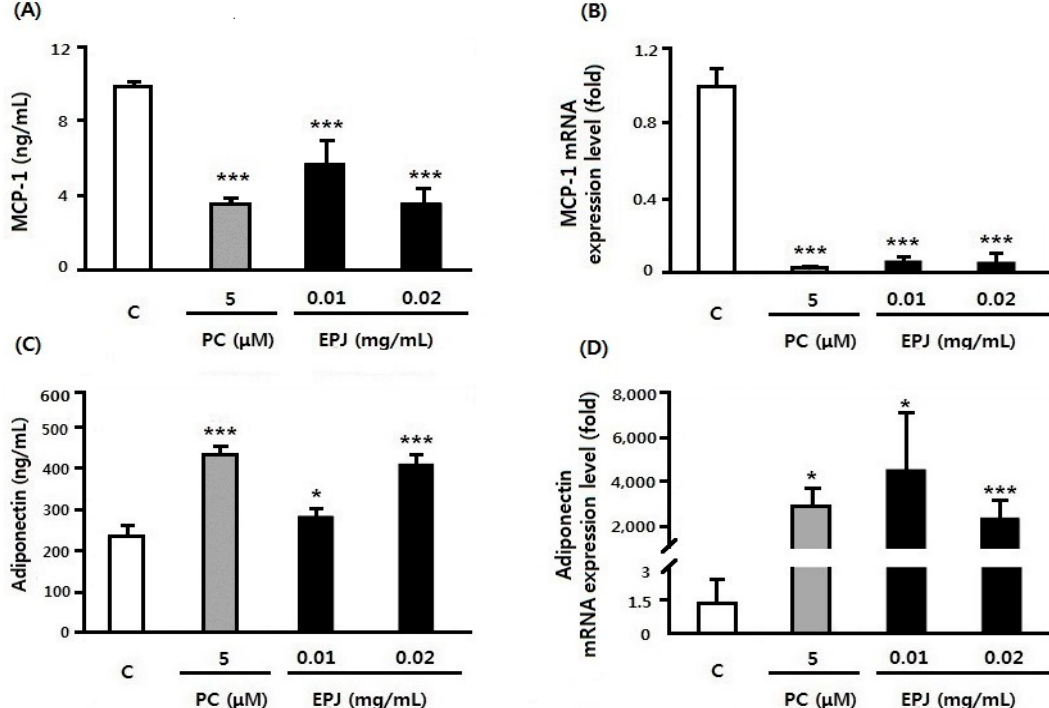
Figure 3. EPJ inhibited MCP-1 and increased adiponectin secretion in di ff erentiated 3T3-L1 adipocytes. The qRT-PCR was performed to detect the expression of MCP-1, adiponectin using 36B4 as the endogenous control. The three treatment groups (PC and both of EPJ groups) were compared with the control ( C ) group. Data are mean ± S.D. of four independent determinations. ( A ) Concentration of MCP-1 (ng / mL). ( B ) mRNA expression level of MCP-1 (fold). ( C ) Concentration of adiponectin (ng / mL). ( D ) mRNA expression level of adiponectin (fold). * p < 0.05, *** p < 0.001.